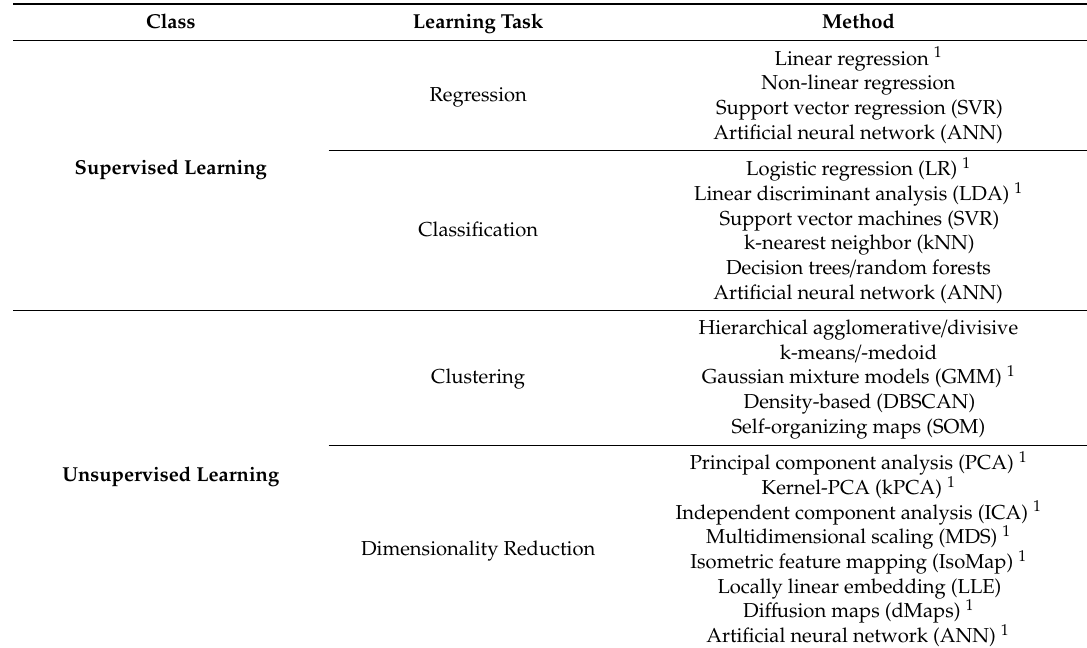
Table 1. Classification of the most popular ML